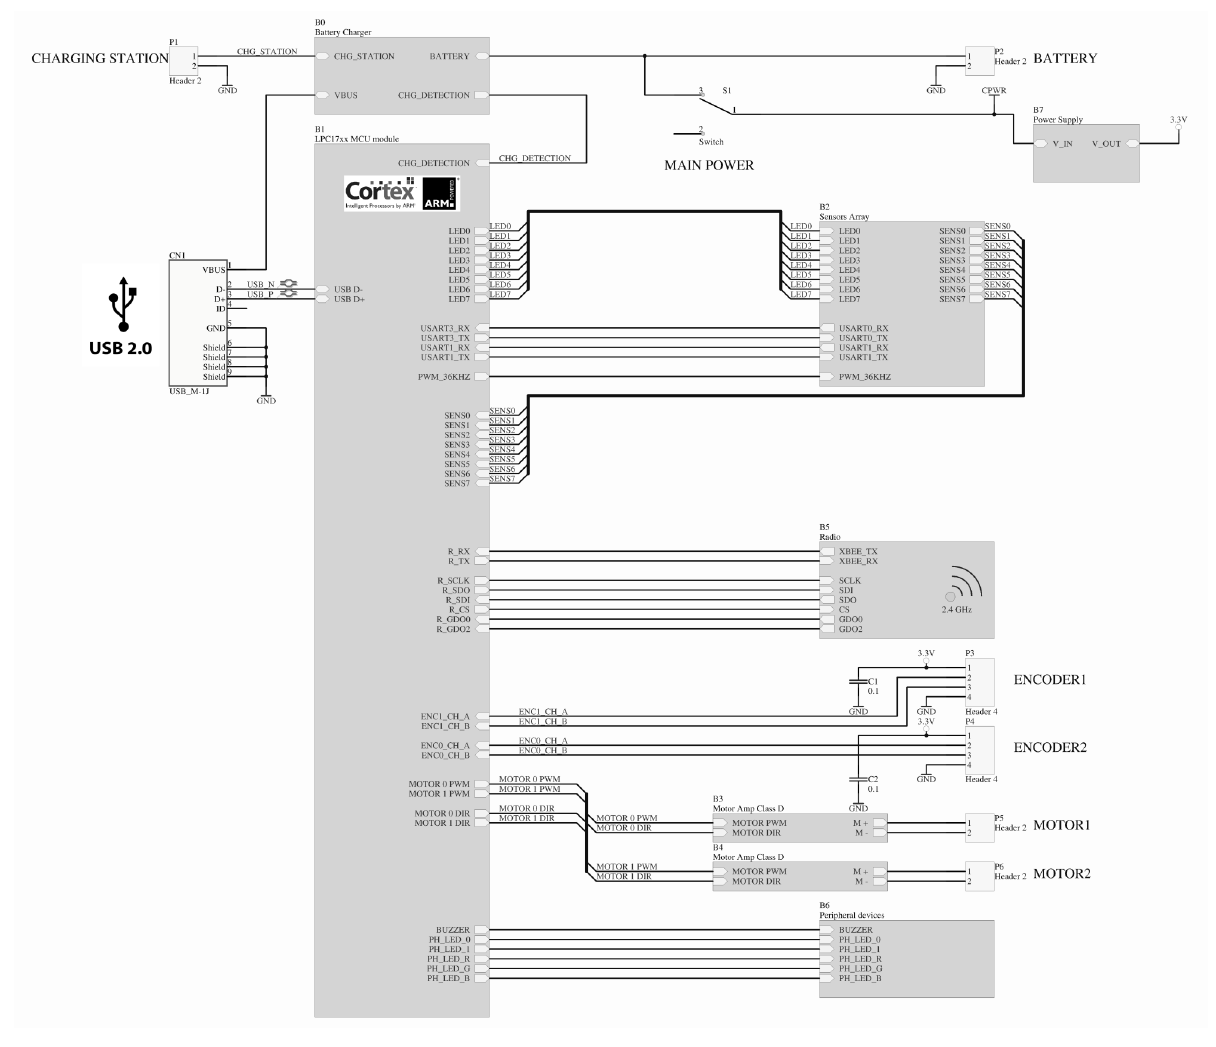
Figure 4: Hardware